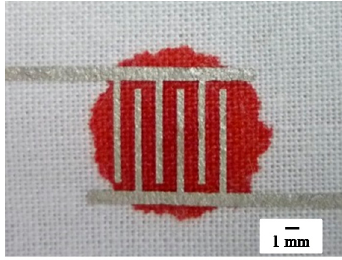
Figure 3. Photograph of the sensor after dropping 15 μ L of blood.